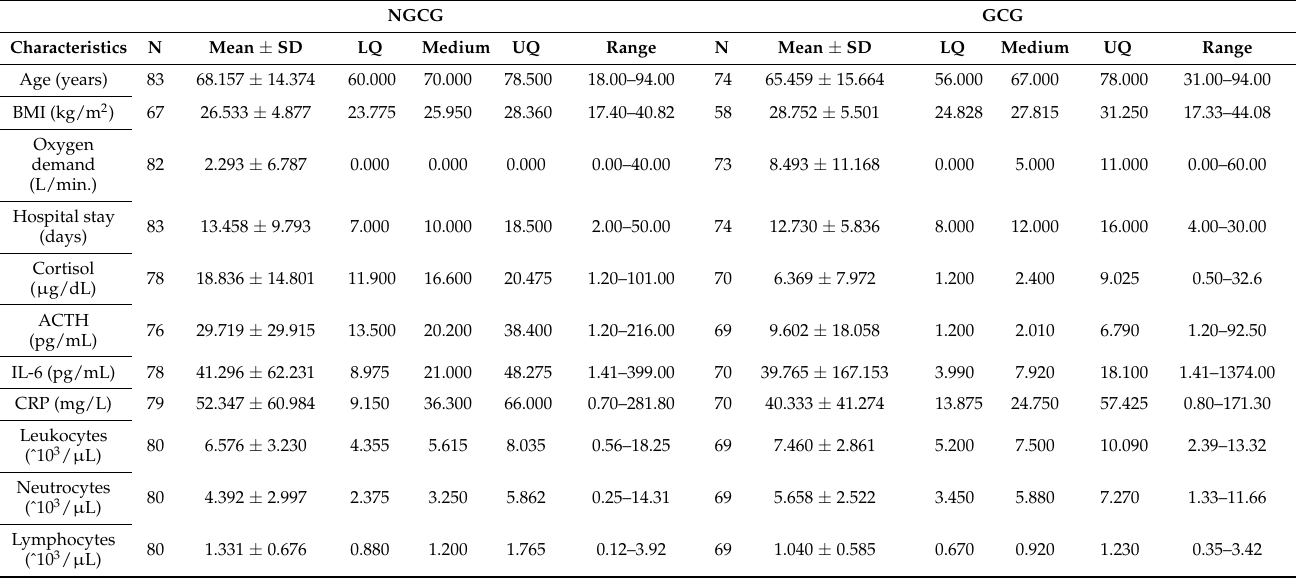
Table 2. Characteristics of the NGCG and the GCG at the time point